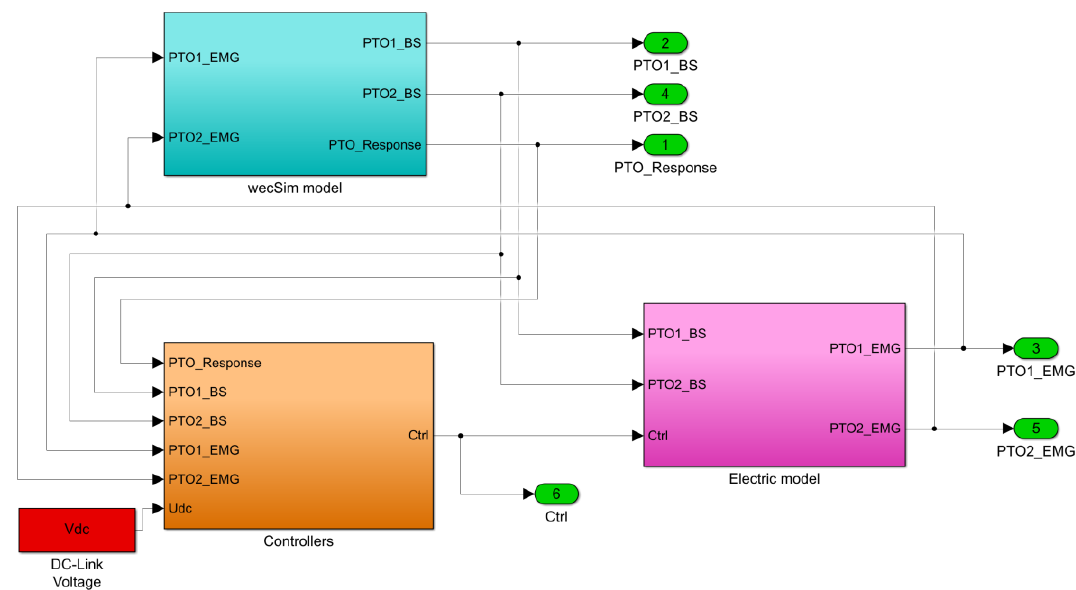
Fig. 10. Components of the SM_PLANT